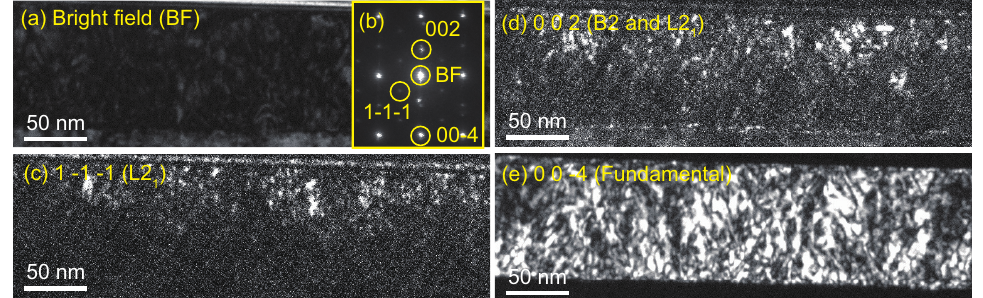
Figure 4. ( a ) Bright-field TEM image and ( b ) electron diffraction image. Corresponding dark-field images for ( c ) the 1 -1 -1 diffraction for the L2 1 phase, ( d ) the 0 0 2 diffraction for the L2 1 and B2 phases, and ( e ) the 0 0 -4, which is a fundamental diffraction of Sample A. The diffraction indexes are shown in ( b ).